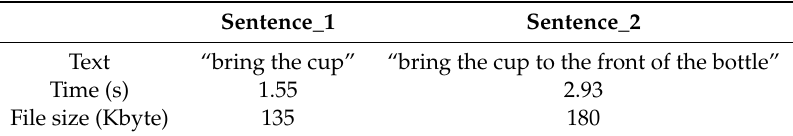
Figure 9. The motion of the service robot executing “bring the cup to the front of the bottle”: ( a ) identify the cup; ( b ) pick up the cup; ( c ) move the hand to the front of the bottle; ( d ) place the cup. Table 6. The sentences and speech signals for testing FaaS-FR.